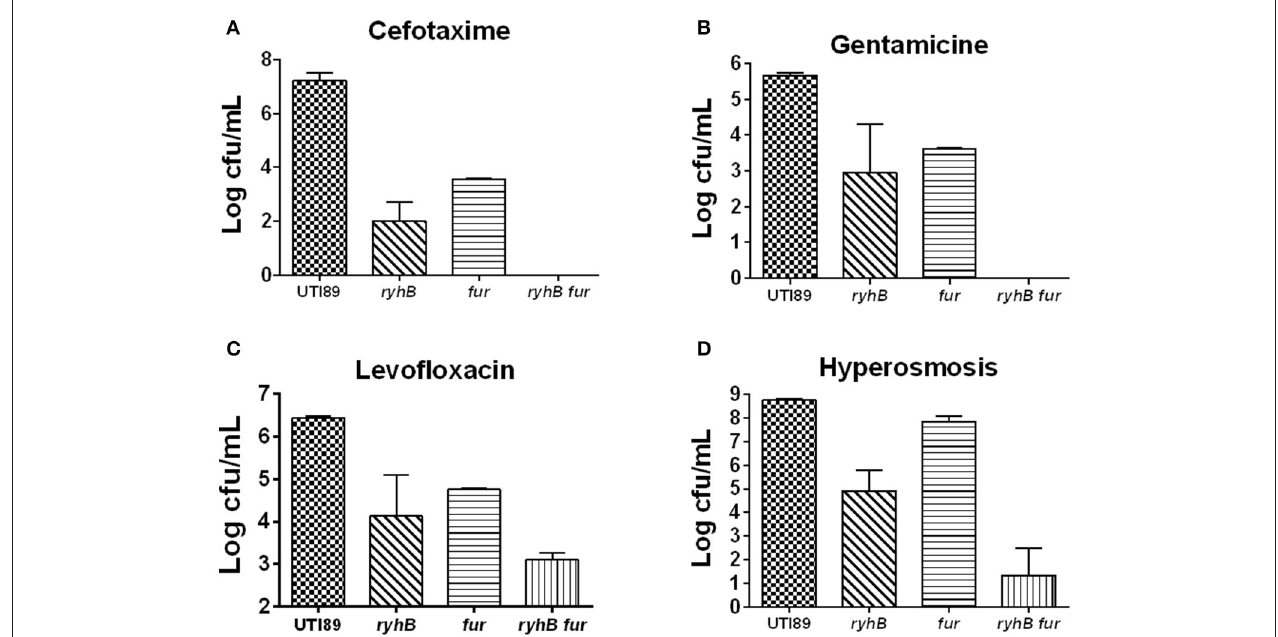
FIGURE 6 | The relationship between RyhB and Fur. Fur-mutant strain 1 fur (fur) , double-deletion mutant 1 ryhB 1 fur (ryhB fur) , including the parent UTI89 and ryhB- mutant strain 1 ryhB ( ryhB ), were cultured for 10h to the stationary phase prior to the addition of antibiotics or stresses. The types of antibiotics or stresses, as well as incubation times, are annotated. (A) Susceptibilities to cefotaxime (128 µ g/mL) at day 5. (B) Susceptibilities to gentamicin (30 µ g/mL) at day 4. (C) Susceptibilities to levofloxacin (5 µ g/mL) at day 3. (D) Susceptibilities to hyperosmosis (NaCl, 4M) at day 2. Error bars show standard variations in CFU between at least three independent